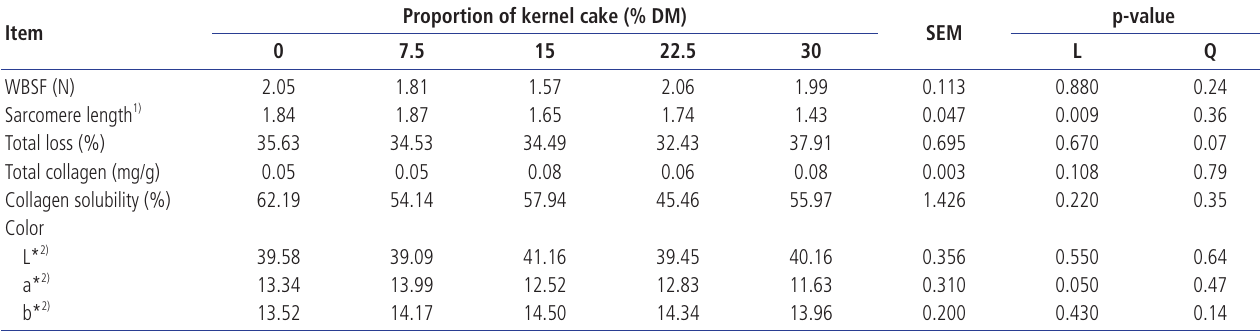
Proportion of kernel cake (%